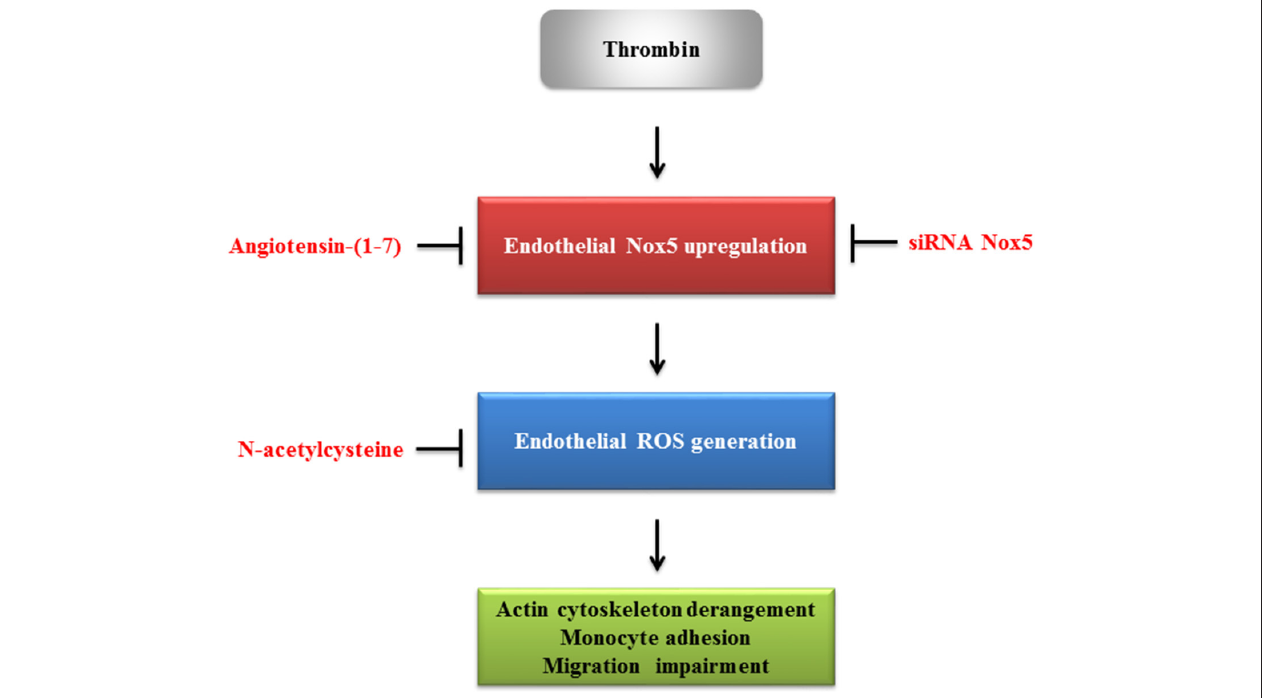
FIGURE 7 | The proposed role of angiotensin-(1-7) in regulating thrombin-induced endothelial phenotypic